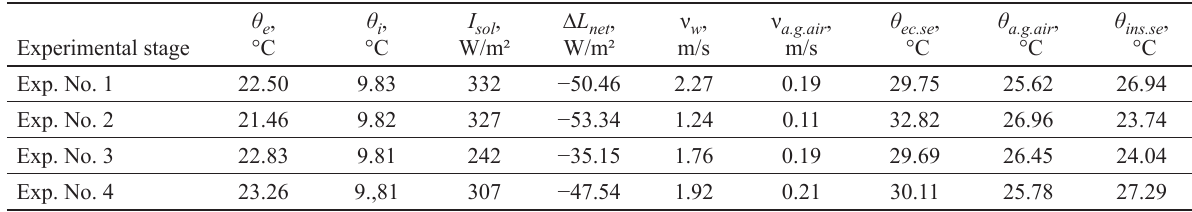
table 3. Average daily data obtained during experiments no. 1–no. 4 Experimental